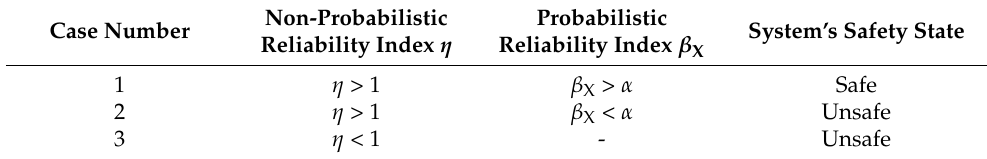
Table 1. Estimation of structural reliability.